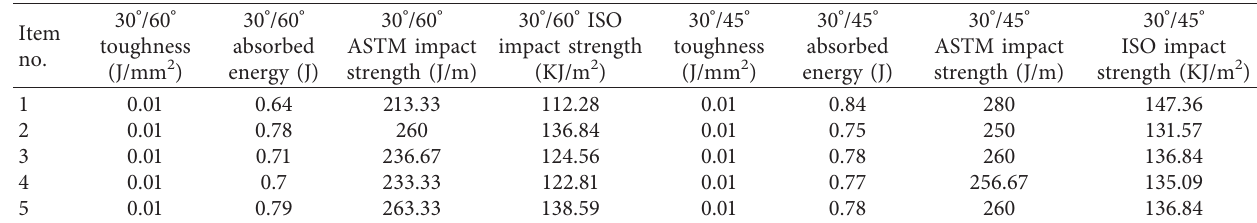
Table 4: Experimental data representing absorbed energy and impact strength for 30 ° /60 ° and 30 ° /45 ° orientation.